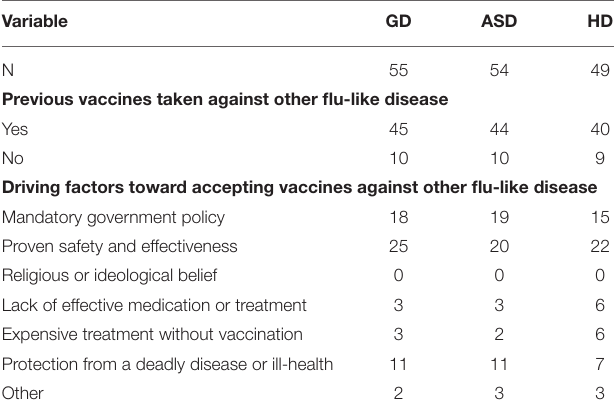
TABLE 3 | Response on compliance to previous vaccinations against other flu-like